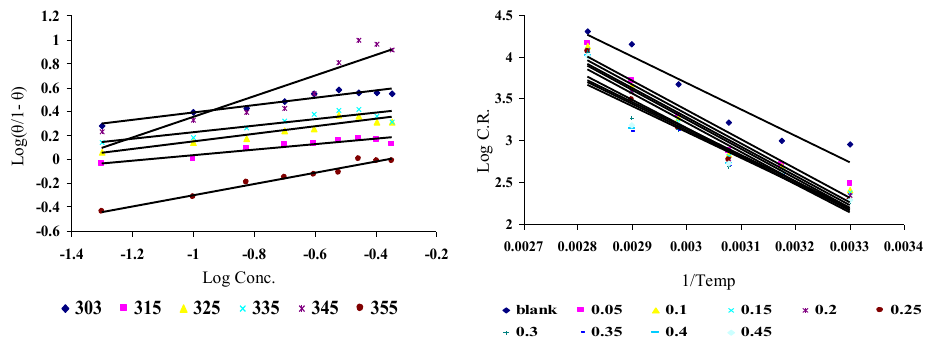
Figure 4. Arrhenius plot of MS in the presence of SFCN extract.